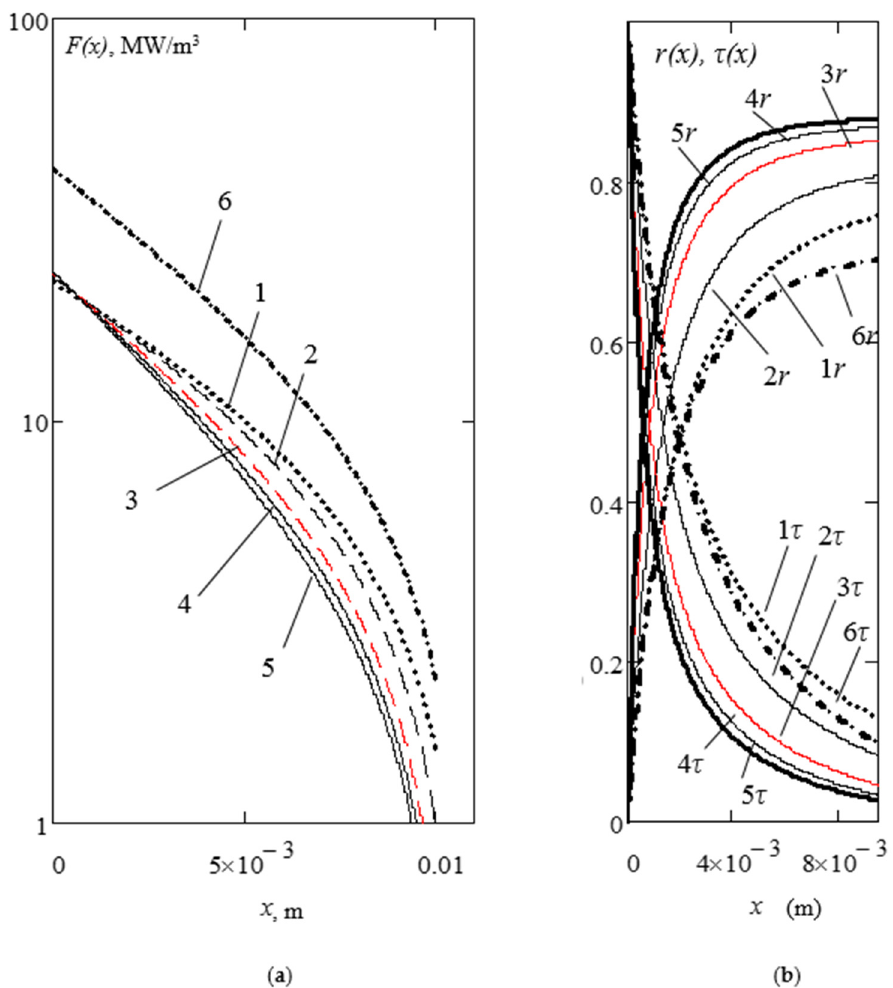
Figure 2. One-dimensional distribution of absorbed radiant energy per time and volume unit F(x) of short wavelength radiation ( a ) and ( b )-volumetric reflection r(x) , transmittance τ (x) coefficients vs thickness x for a single semitransparent layer for optical models M se1 —curves 1, M se2 —2, M se3 —3 (experimental optics—red curves), M se4 —4, M se5 —5, and M se6 —6 (See Figure 1b; Table 2).